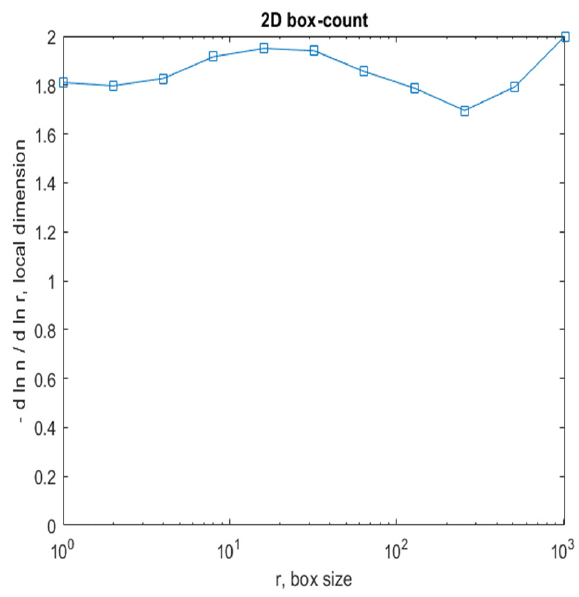
Figure 12. Two ‐ dimensional box ‐ count algorithm: fractal dimension. Figure 12. Two-dimensional box-count algorithm: fractal